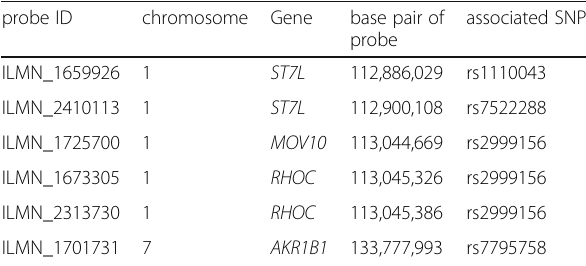
Table 2 SMR of Westra et al. eQTLs and whole-body lean mass